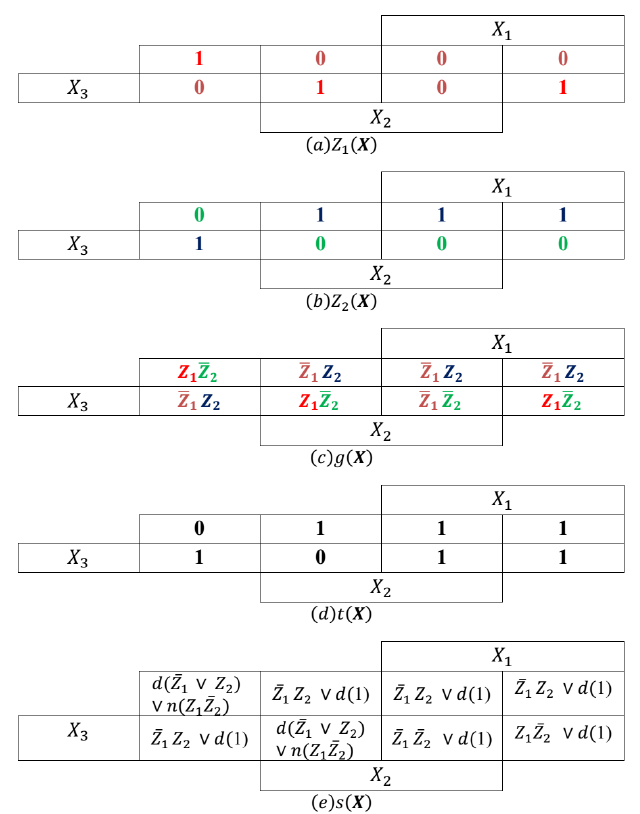
Fig. 2. Maps illustrating the evolution of the solution of the Example in Sec.